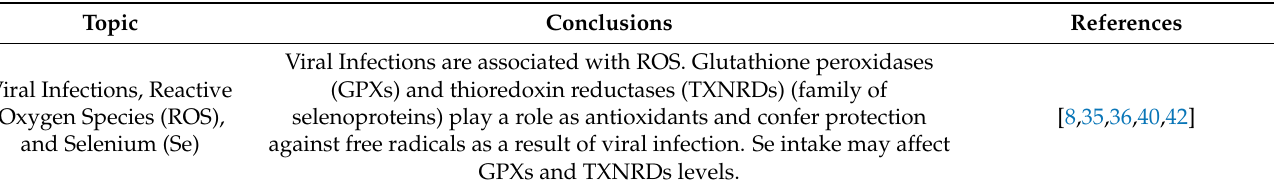
Table 1. Summary of Selenium